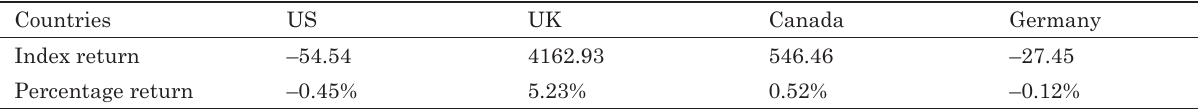
Table 6. The return of the securitized real estate indices of the four countries by the trading strategy according to the Shiryaev-Zhou index, with the presence of 0.5% buying cost